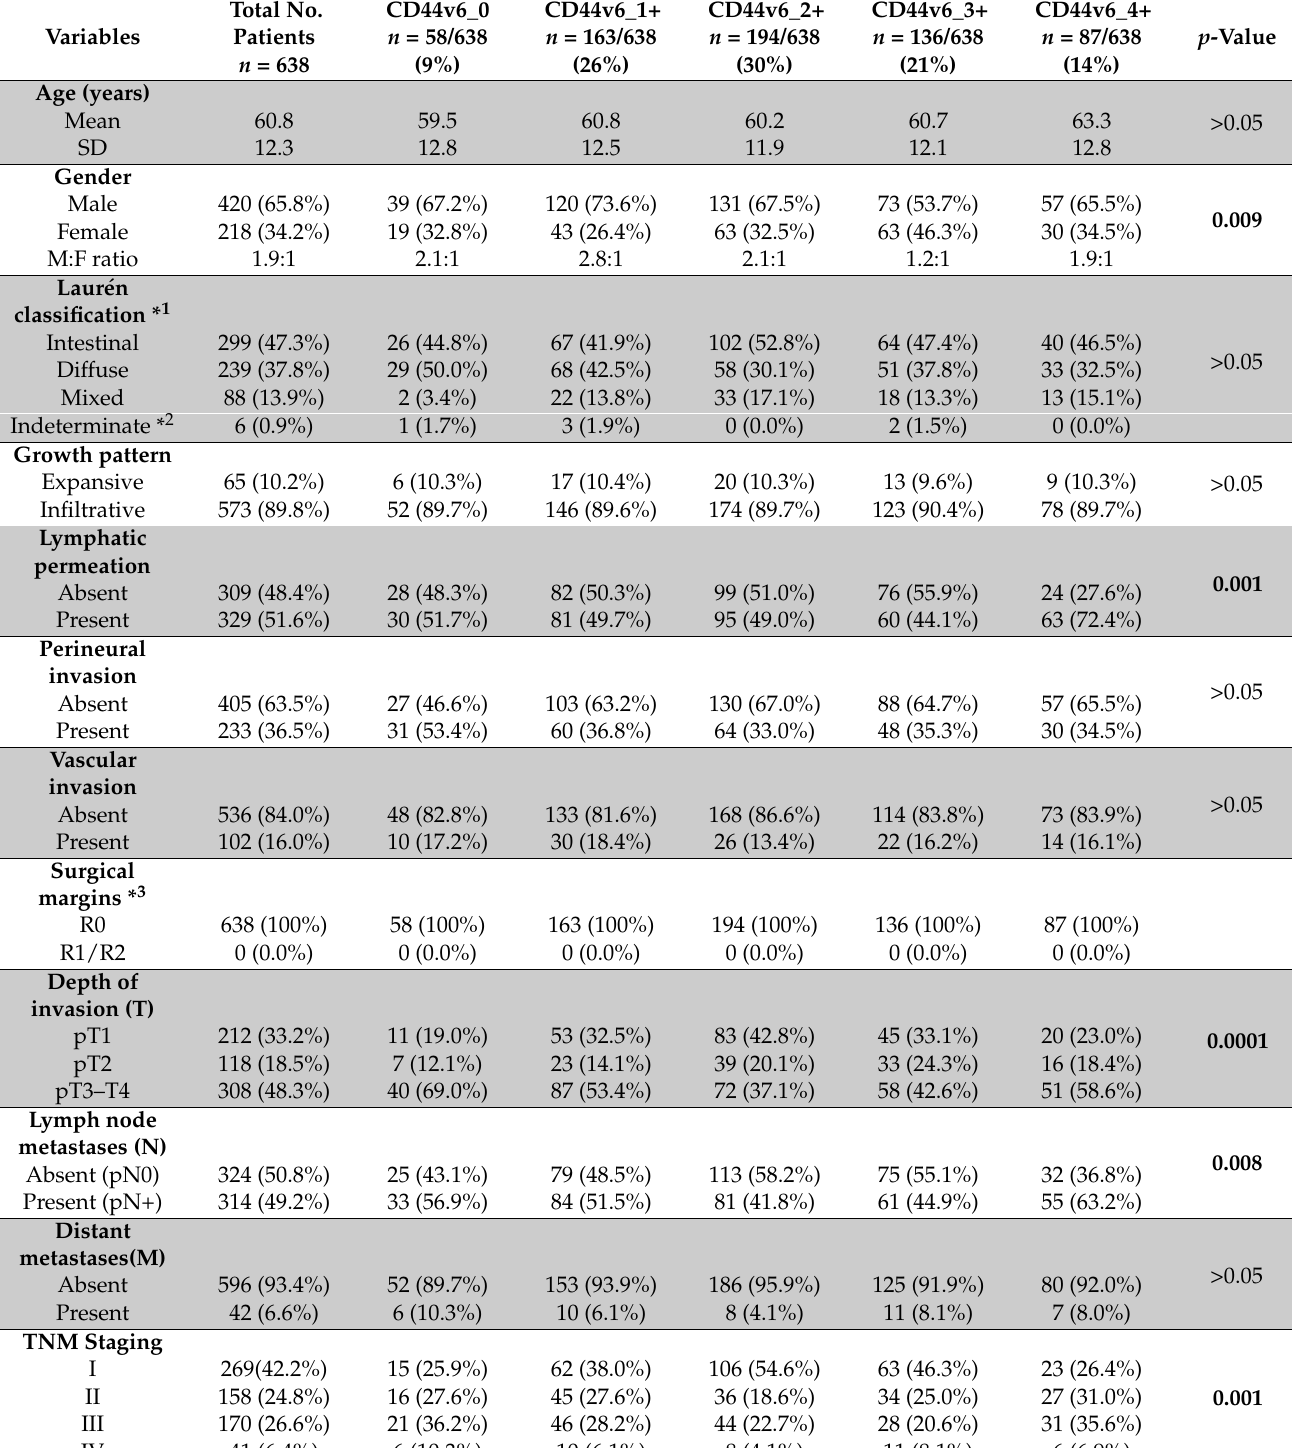
Table 2. Clinicopathological associations with extent of CD44v6 expression in gastric tumors from the SNUH cohort.